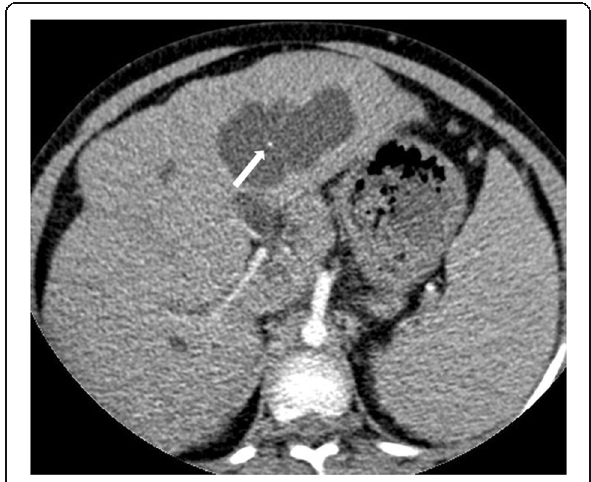
Fig. 5 A 6-year-old male patient with known Caroli syndrome. Axial plane arterial phase CT image shows central dot sign